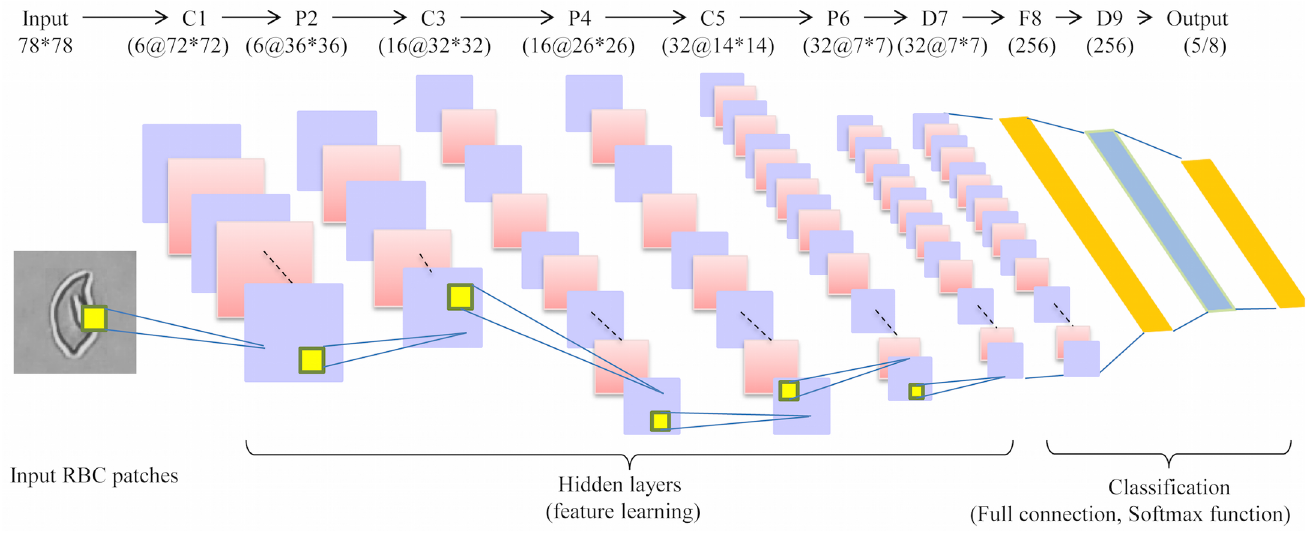
Fig 7. Architecture of deep RBC-dCNN for SCD RBC classification.